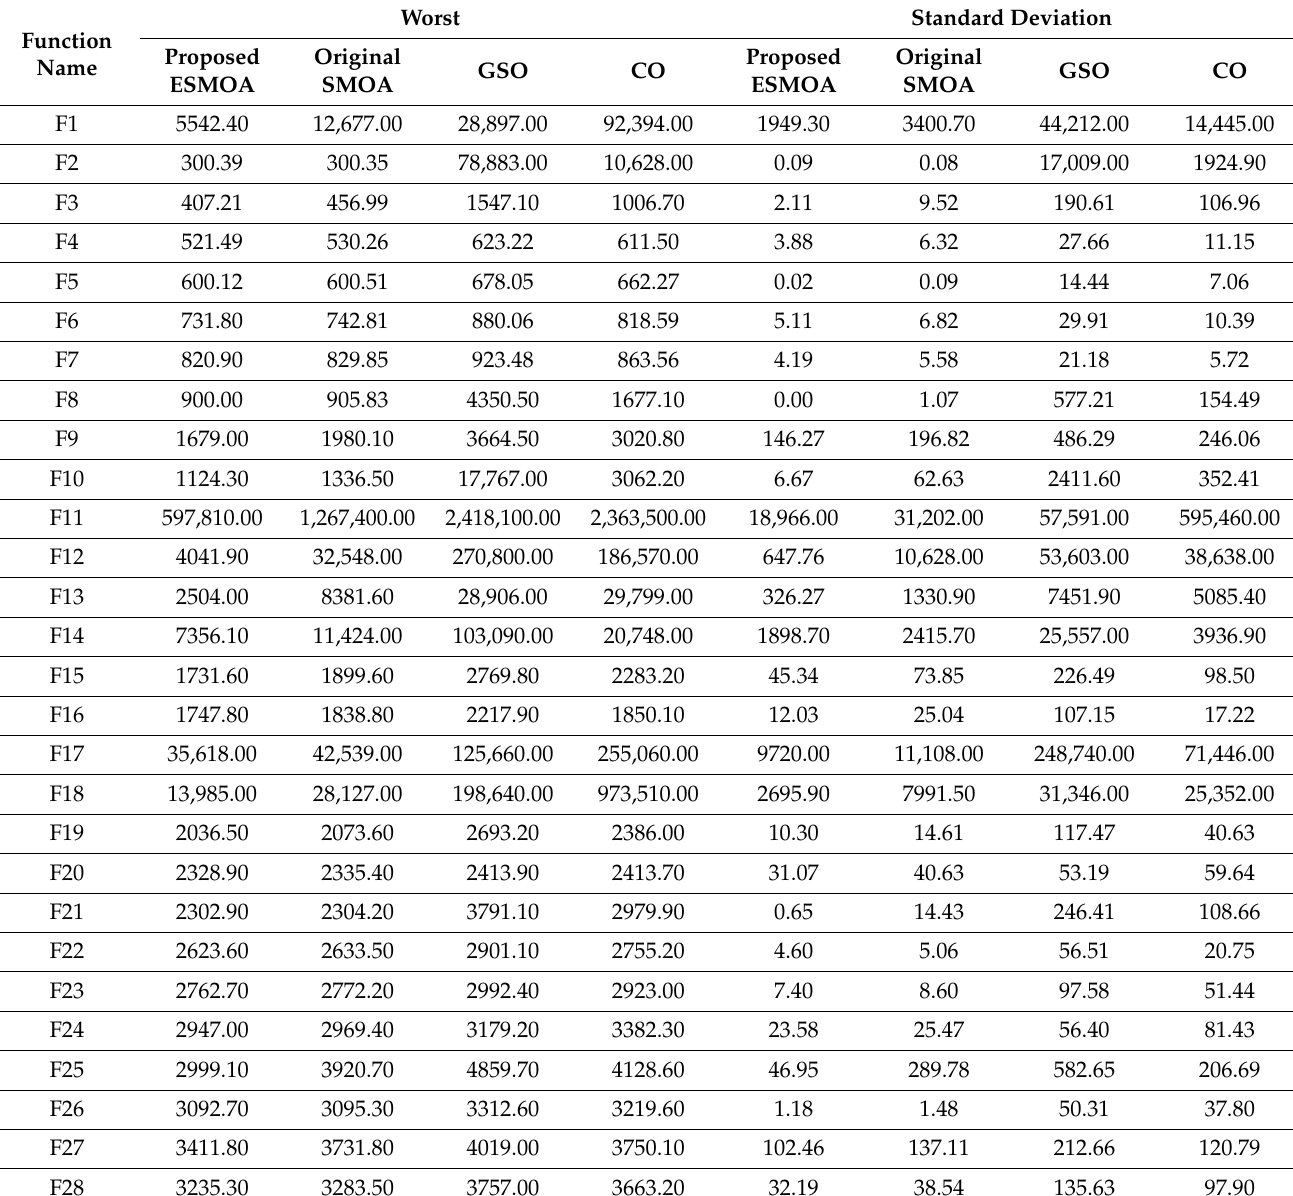
Table 2. Worst and standard deviations of the comparative algorithms for the 28 benchmark